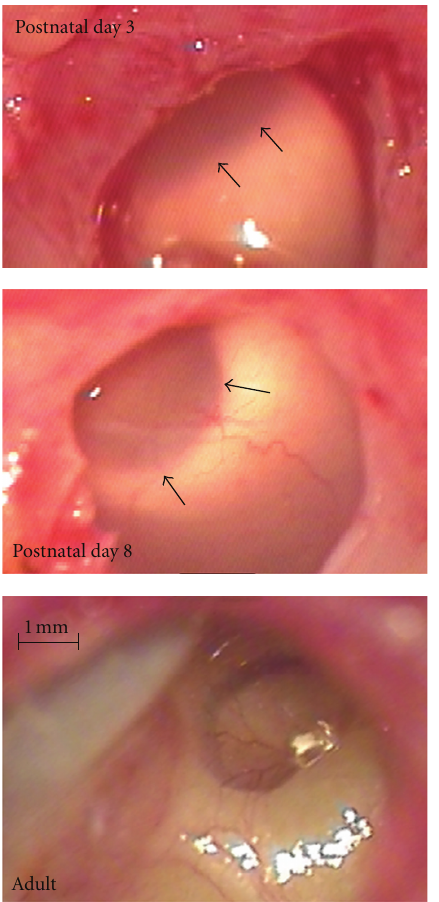
Figure 2: Photographs of the bulla in animals of the youngest group, compared to an adult animal. At postnatal days 0 and 3 (top), the bulla was filled with milky viscous tissue that covered the round window (its rims show through, marked by arrows). At postnatal day 8 (middle), the tissue was more translucent. In all older animals investigated, the bulla was fully pneumatized and did not show any further developmental changes (bottom).